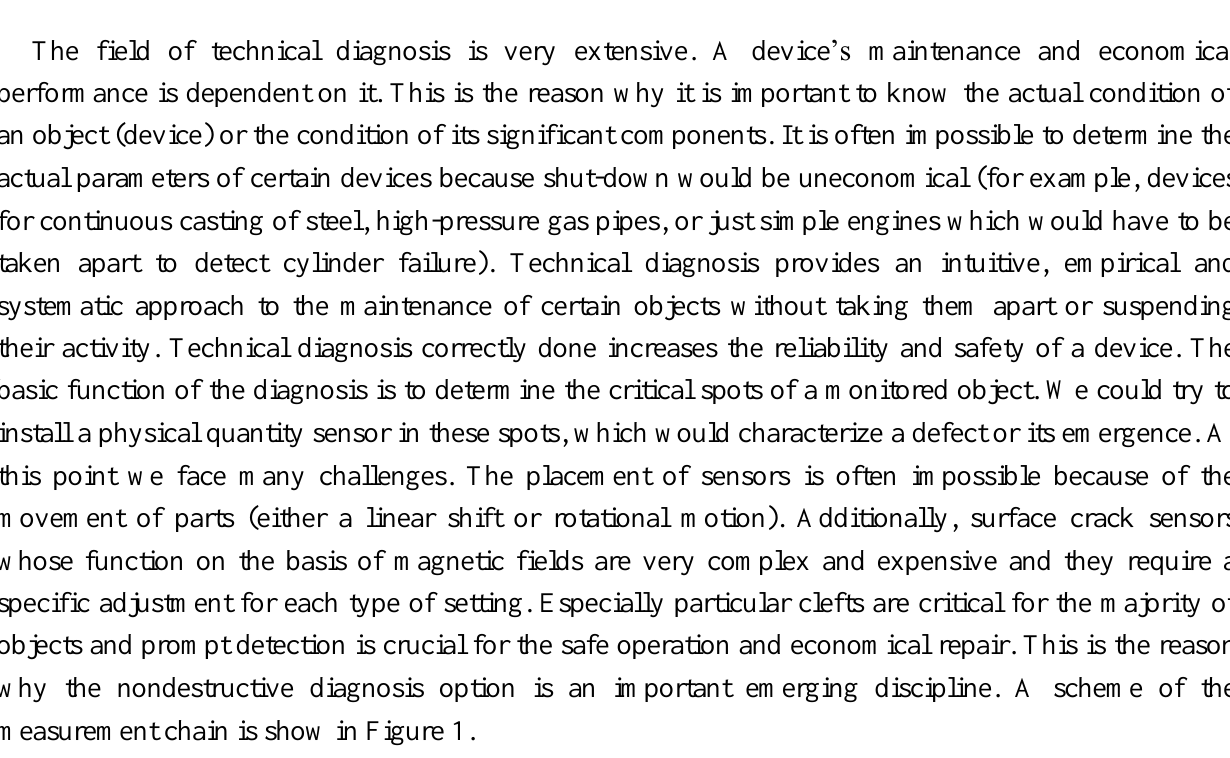
Figure 1. Schema of measuring network and procedure of data process. All operations are performed on a physical model of a